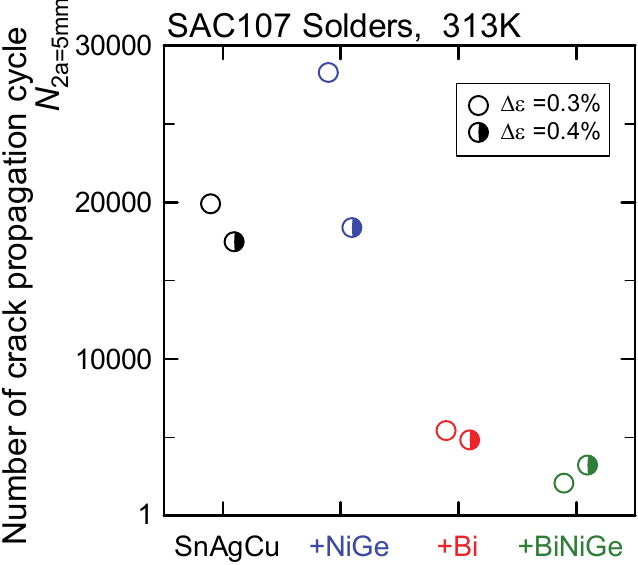
Figure 8: Effect of additive elements on crack propagation